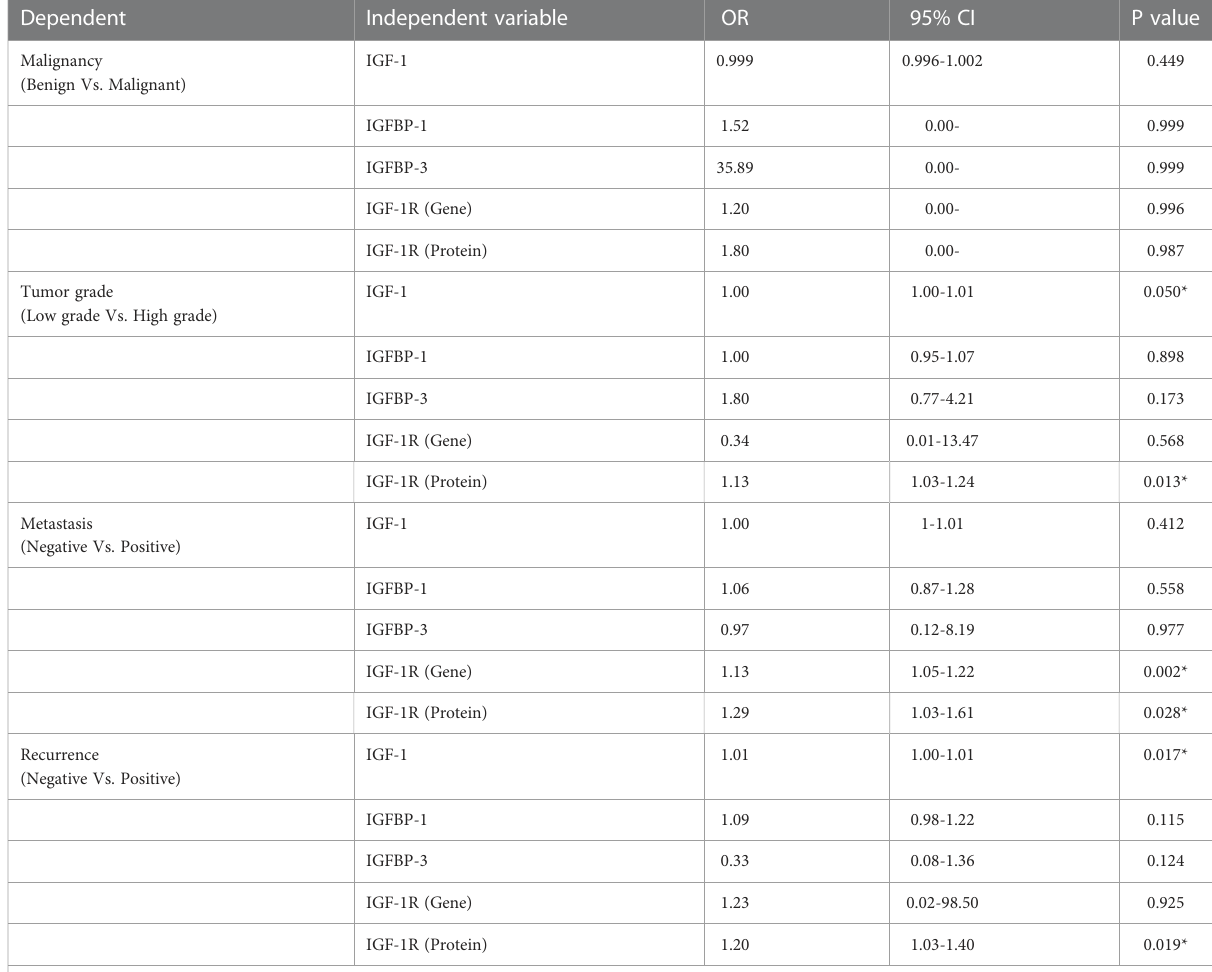
TABLE 3 The regression of IGF axis (Logistic